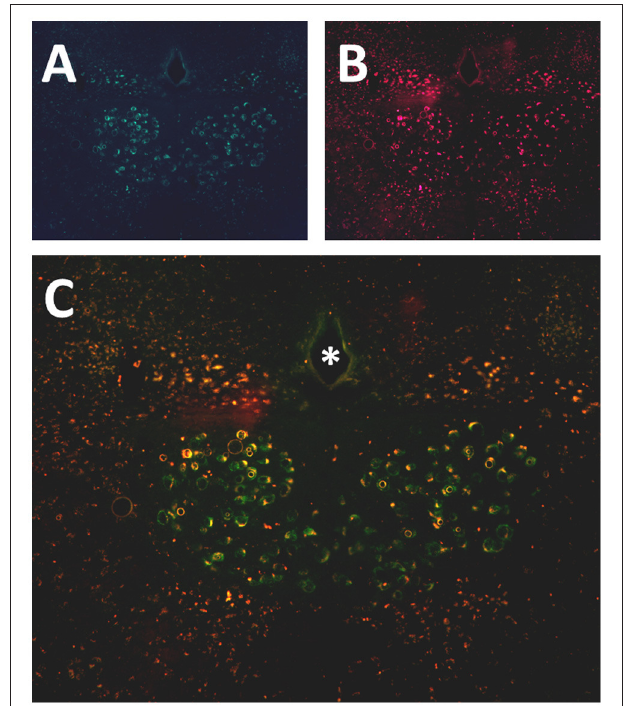
FIGURE 3 | Localization of AAV5-hSyn-hM4 (Gi)-mCherry and fluorescently labeled cholera toxin B (CTB-AF488) in the hypoglossal nucleus. Fluorescent microscopy images ( × 20) shows (A) CTB labeled motoneurons more caudally, at the obex level of the hypoglossal nucleus, following genioglossal injection; (B) mCherry expression in the same section; (C) merged mCherry and AF488 images. * denotes central